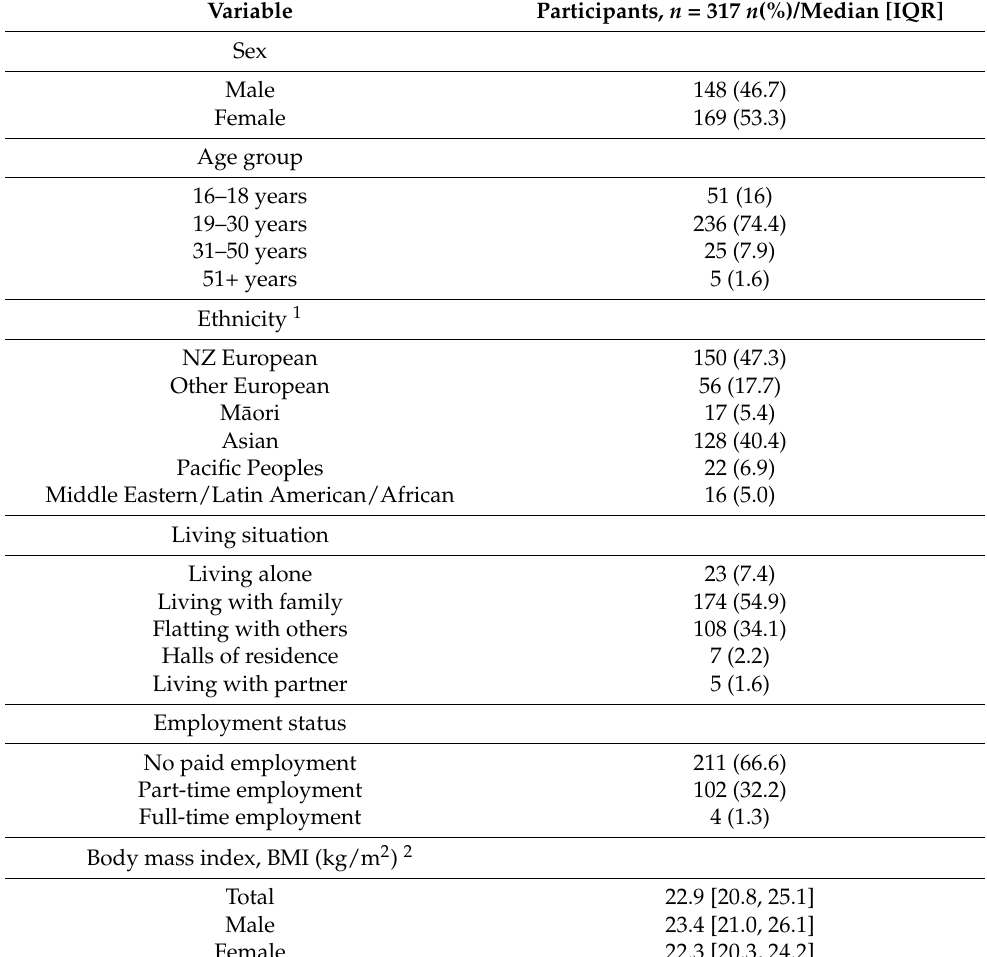
Table 1. Socio-demographic and anthropometric characteristics, sources of